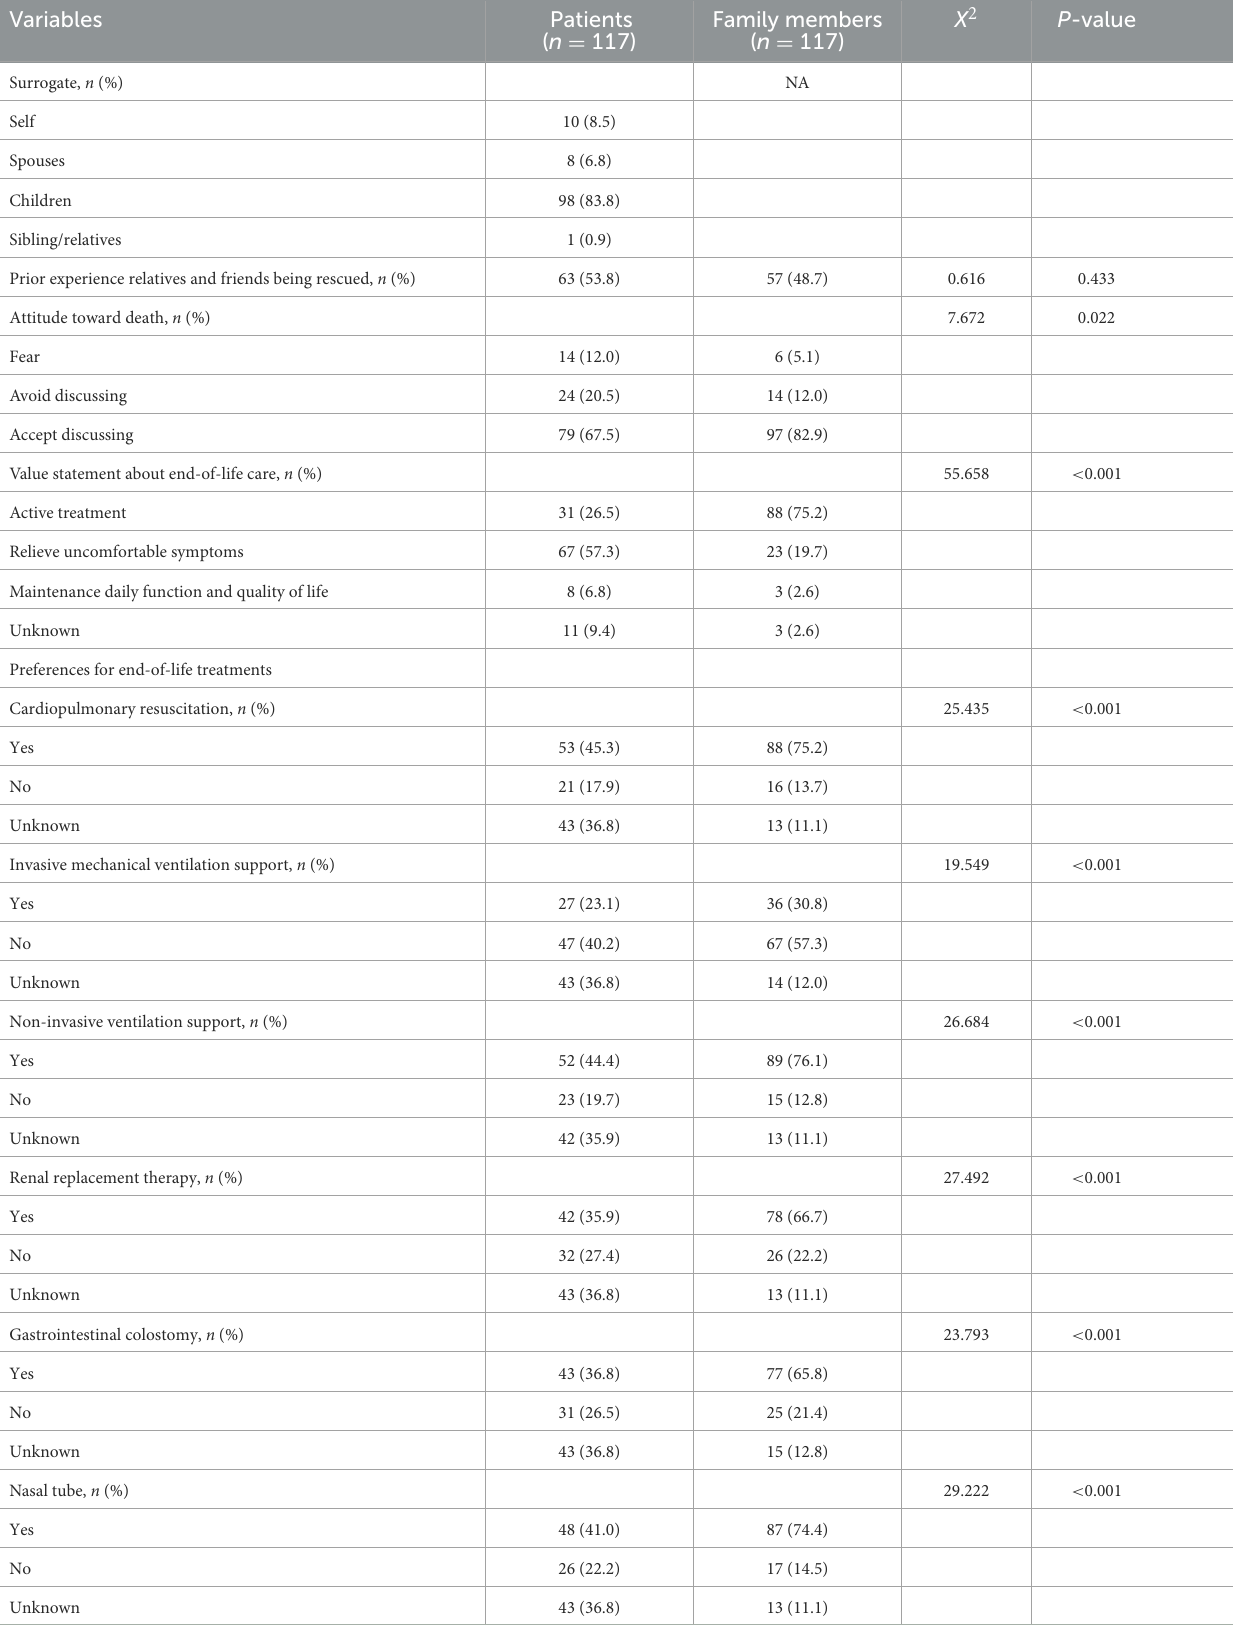
TABLE 2 Comparison of attitudes of older patients and their family members toward ACP and end-of-life treatments for the patients. Variables Patients ( n =